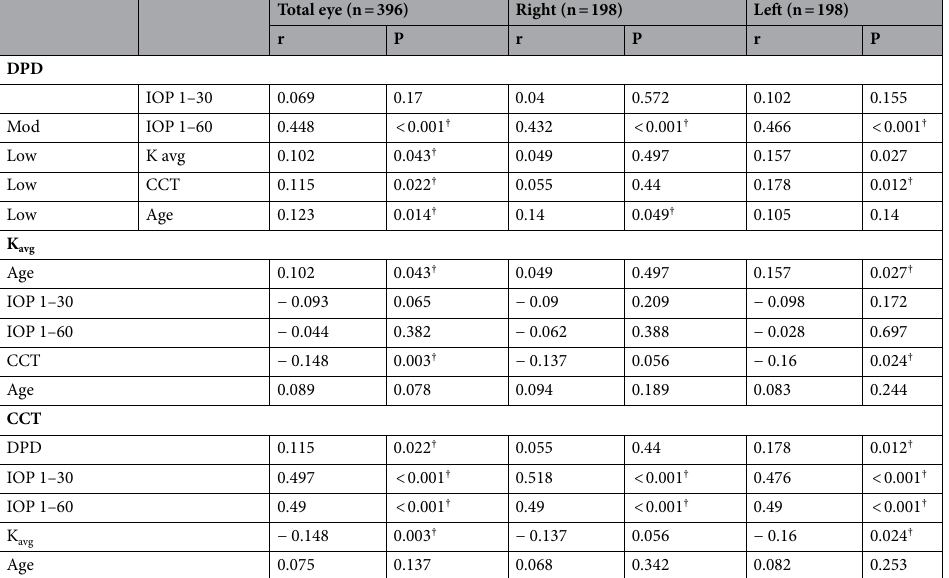
Table 4. Correlations between ocular parameters. Partial correlation test, controlled for the effects of sex. r correlation coefficient, IOP 1–30 intraocular pressure in mm Hg (1–30 mode), IOP 1–60 intraocular pressure in mm Hg (1–60 mode), DPD differential pressure difference in mm Hg, K avg average keratometric value in diopters, CCT central corneal thickness in micrometers. Low negative correlation coefficient: − 0.29 to − 0.10. Moderate negative correlation coefficient: − 0.49 to − 0.30. High negative correlation coefficient: − 0.50 to – 1.00. Low positive correlation coefficient: 0.10 to 0.29. Moderate positive correlation coefficient: 0.30 to 0.49. High positive correlation coefficient: 0.50 to 1.00.